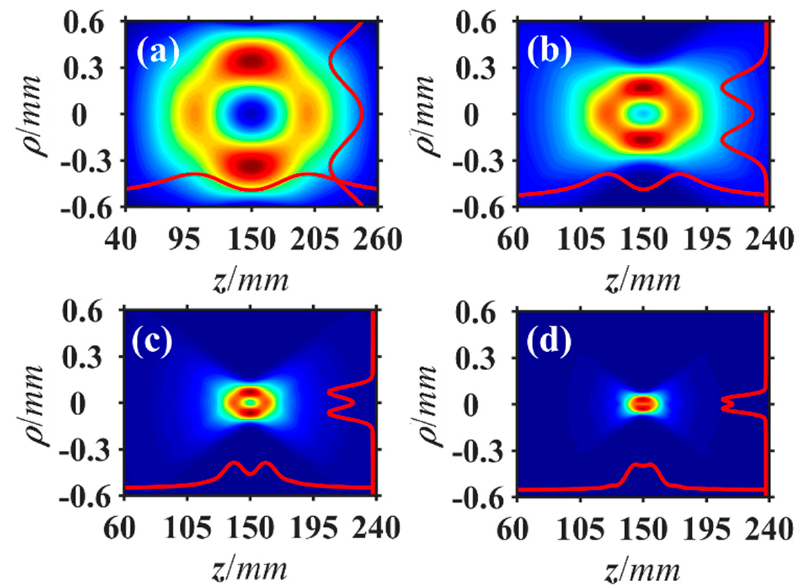
Figure 2. Normalized intensity distribution of an apertured BGCSM beam focused by a thin lens in the ρ – z plane for different values of transverse coherence width δ 0 with a = 1.5 mm and β = 2.5. ( a ) δ 0 = 0.1 mm; ( b ) δ 0 = 0.2 mm; ( c ) δ 0 = 0.5 mm; and ( d ) δ 0 = 1 mm.